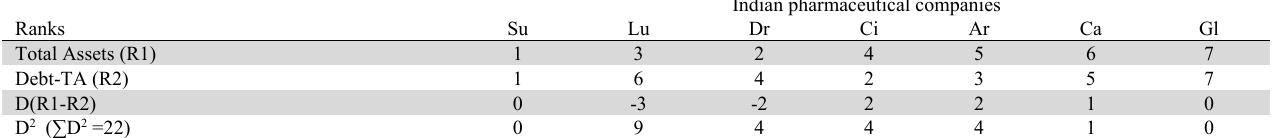
Originating Source: R1 and R2 from Table 1 and Table 9.